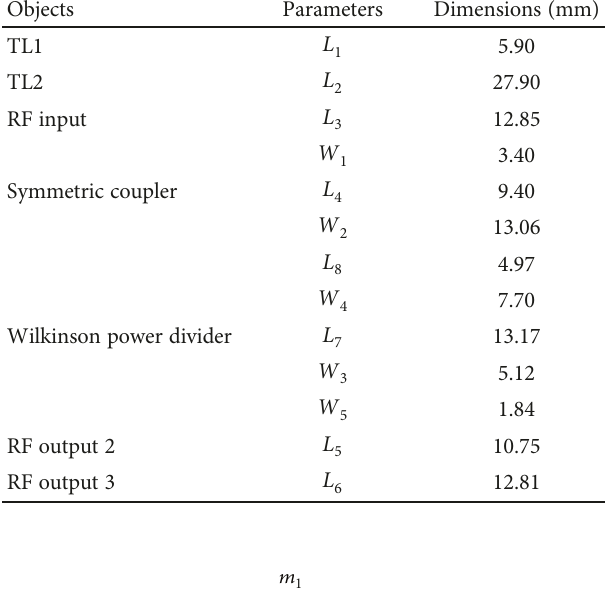
Table 1: Parameters of the three-port power divider. Objects